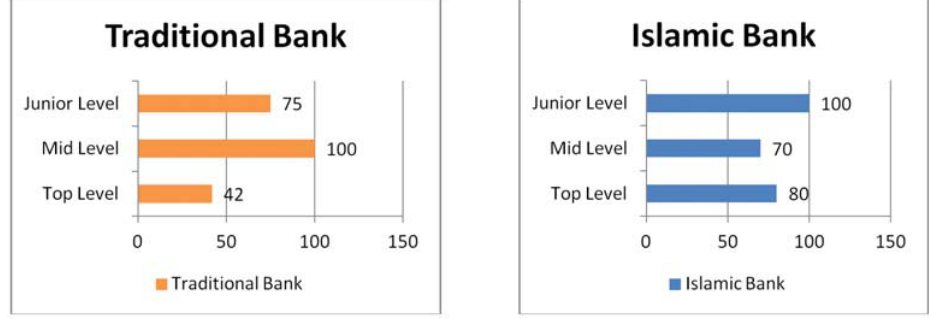
Fig. 5. Different level of management perception on CSR